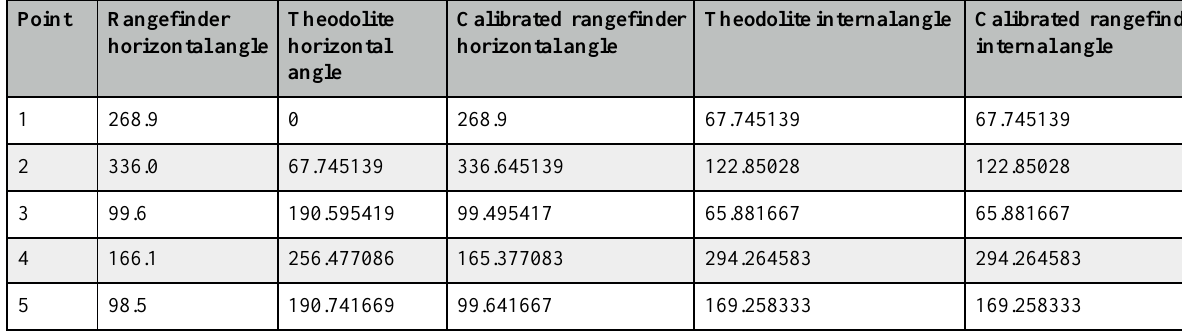
Table 7: Calibration of room 10 rangefinder horizontal angle measurements by homotopies